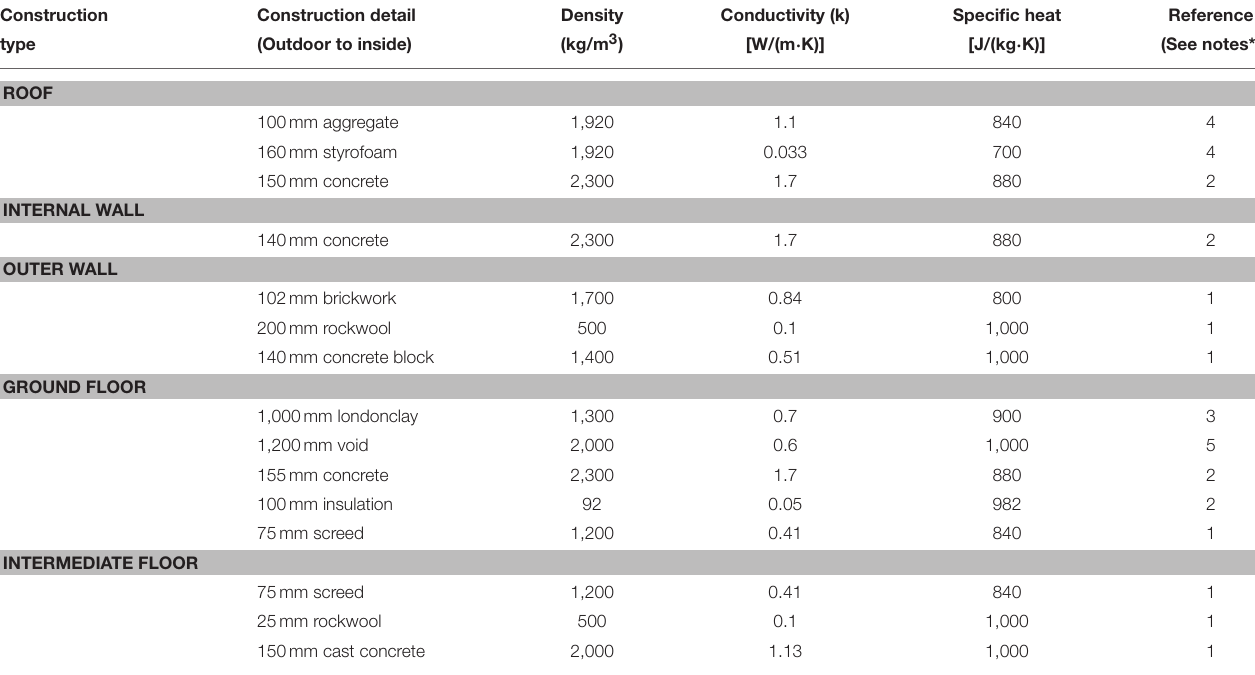
TABLE 2 | Characterization of the building opaque envelope.